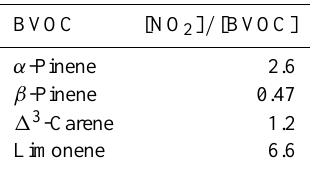
Table 5. Minimum [NO 2 ] / [BVOC] value reported for each monoterpene studied at which NO 3 is expected to dominate night- time oxidation.